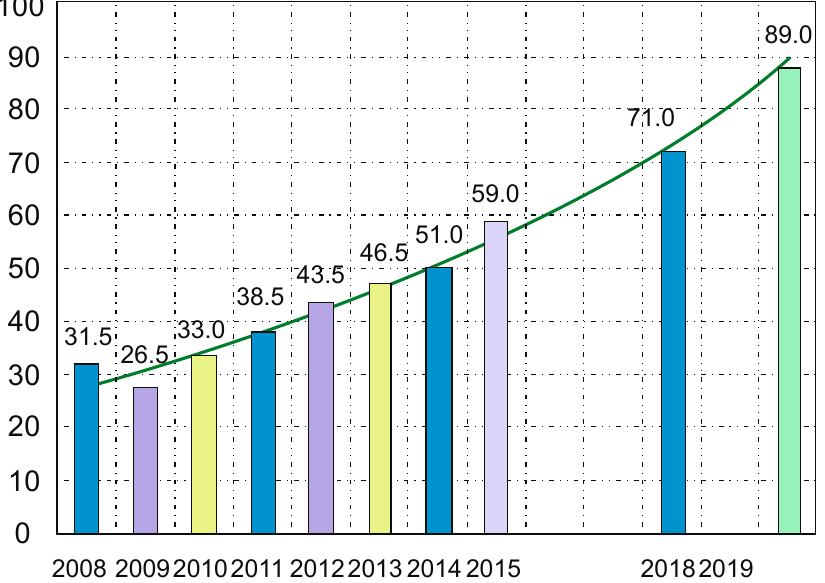
Figure 1. The development of the use of composites in recent